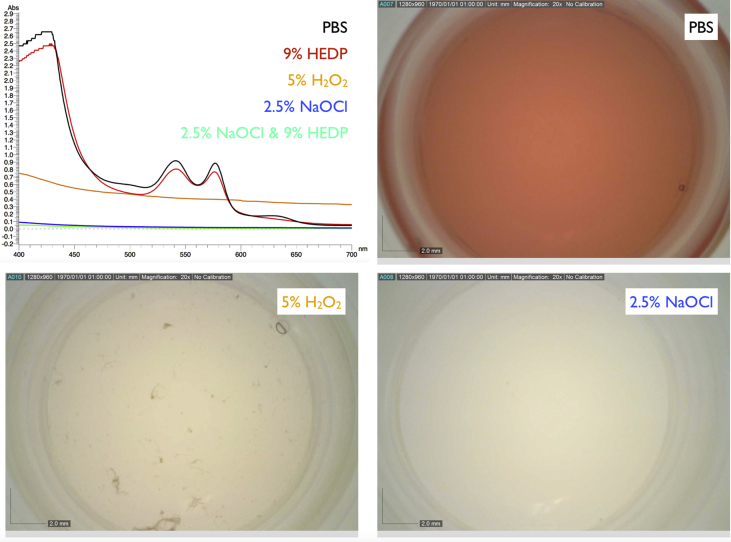
Top left: Absorption patterns of human whole blood mixed with different irrigants (1:80 mixtures, 5 min). The typical double peak of oxygenated hemoglobin can be seen in mixtures of full blood and PBS as well as HEDP, indicating that the latter did not affect the iron in the hem that binds the oxygen. Photographic images show the typical red color of blood mixed with PBS (top right), the bleaching effect of H2O2 with denatured protein remnants (bottom left), and the complete dissolution of all visible blood constituents by NaOCl (bottom right).